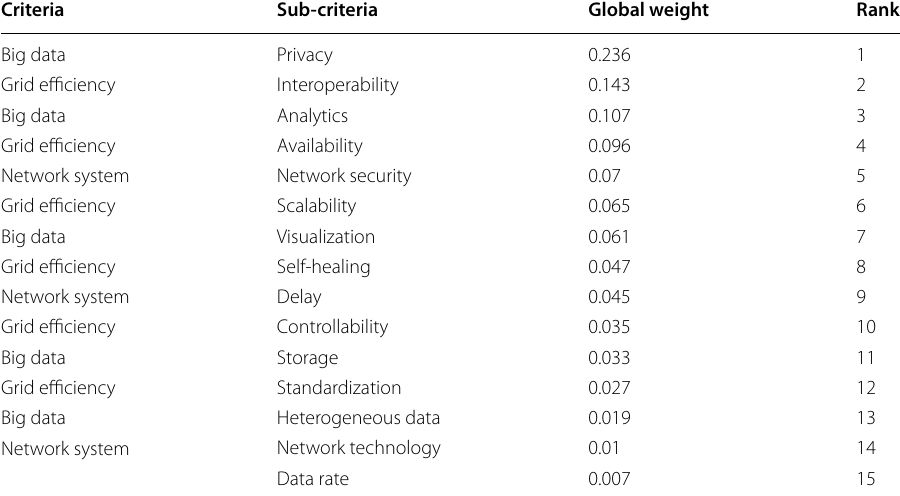
Table 2 Global weights and ranking for sub-criteria